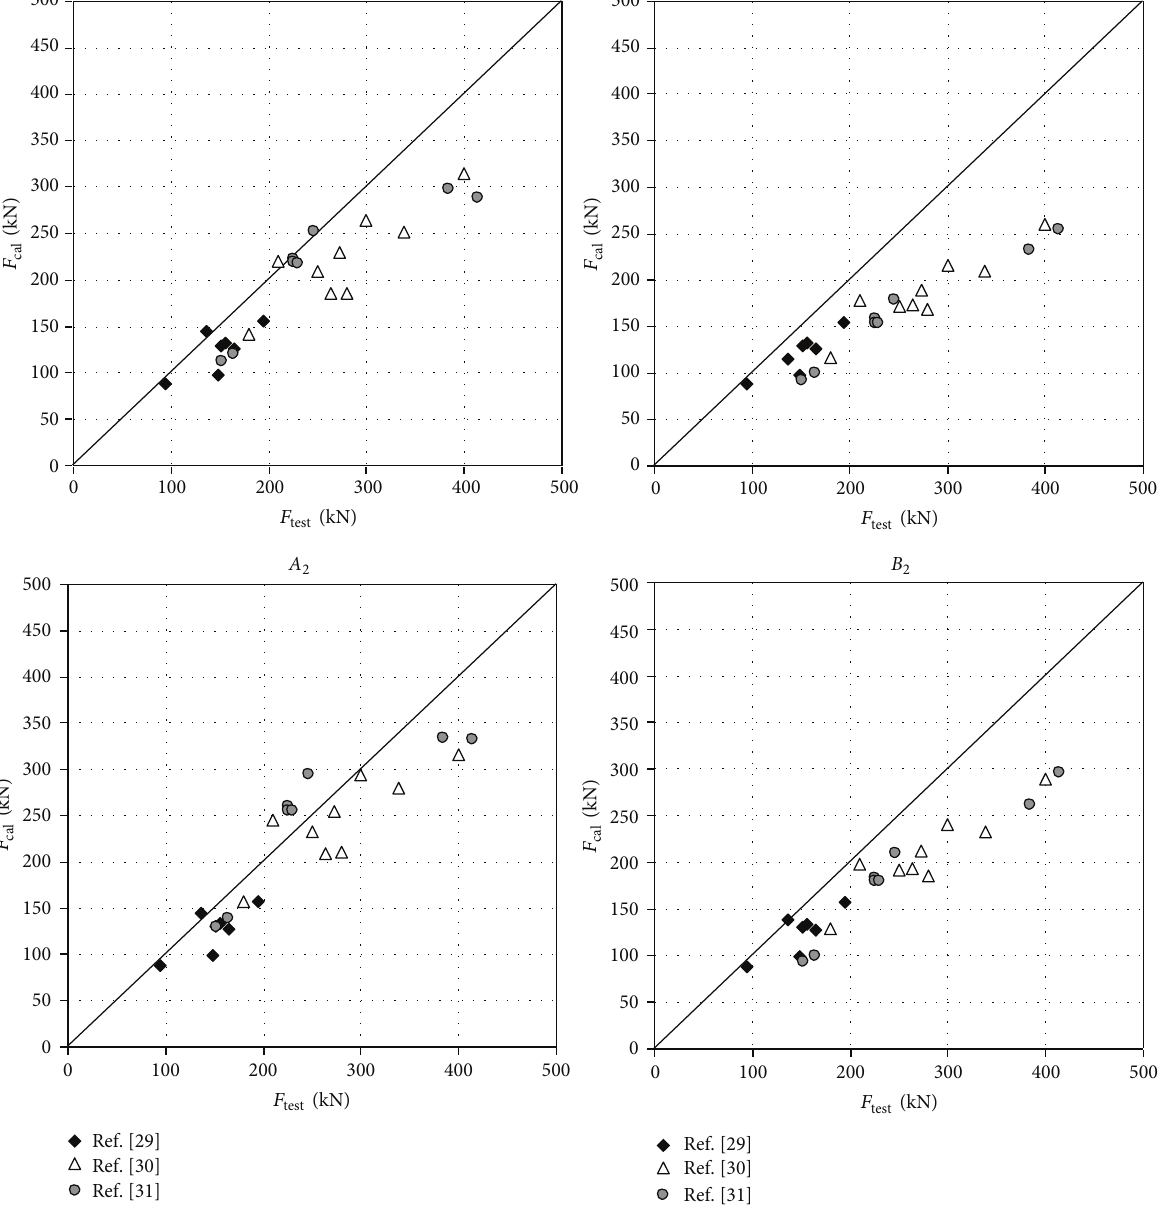
Figure 6: Comparison with experimental data in the four cases